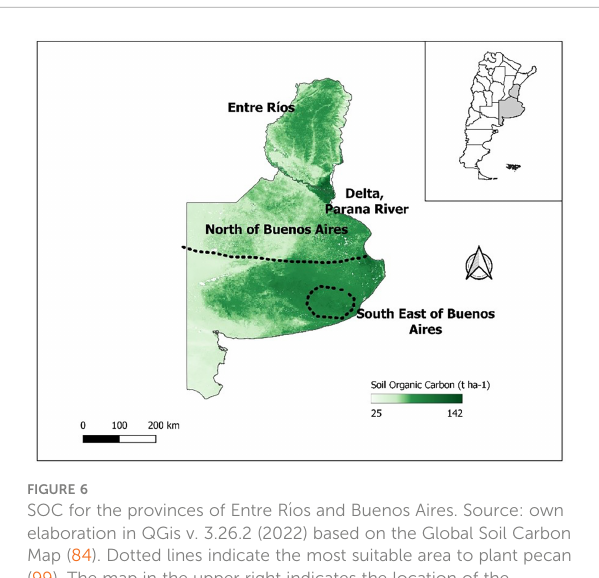
FIGURE 6 SOC for the provinces of Entre R ı ́ os and Buenos Aires. Source: own elaboration in QGis v. 3.26.2 (2022) based on the Global Soil Carbon Map (84). Dotted lines indicate the most suitable area to plant pecan (99). The map in the upper right indicates the location of the provinces within Argentina.